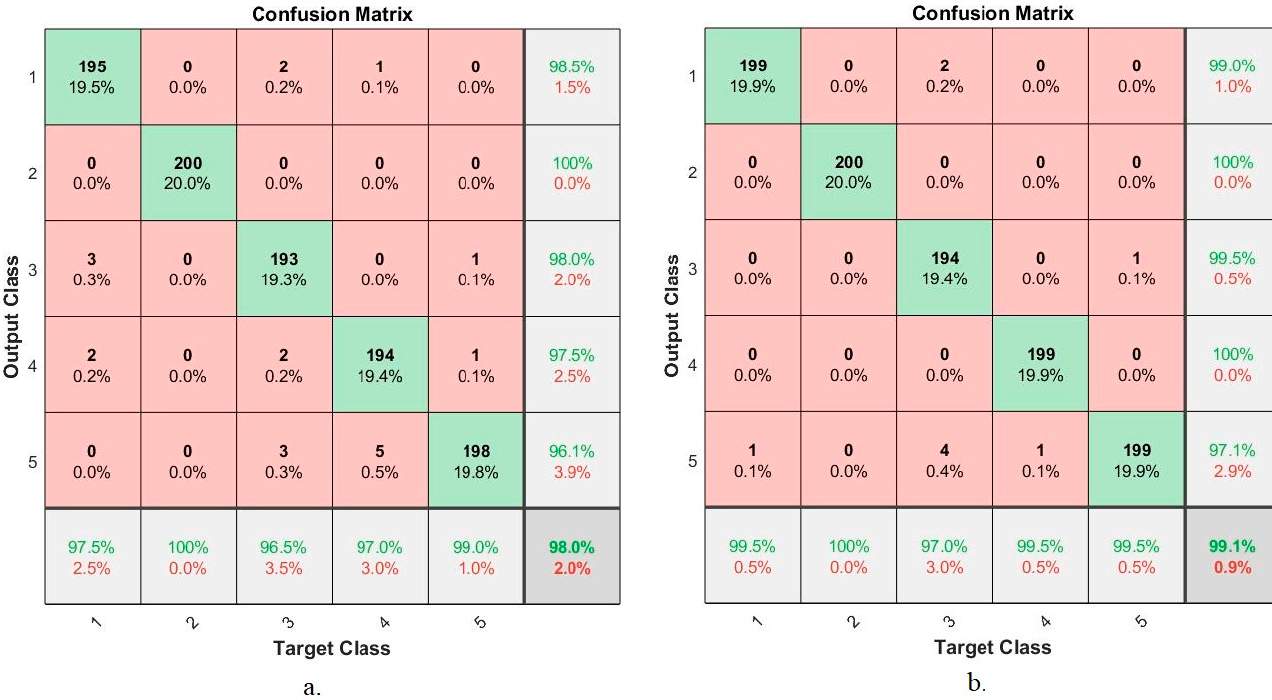
Figure 23. Performance results of the ANN for diagnosing lower gastrointestinal diseases based on hybrid features ( a ) GoogLeNet with traditional algorithm and ( b ) AlexNet with traditional algorithm.